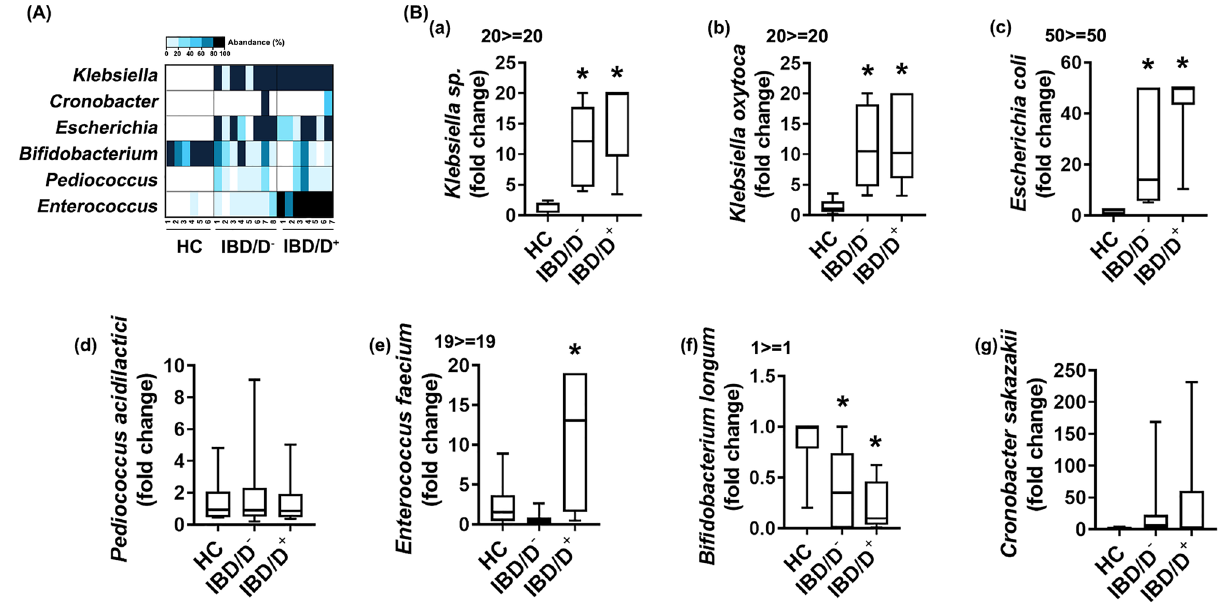
Figure 1. The fecal microbiota composition of patients with IBD/D − or IBD/D + and healthy individuals (HCs). ( A ) Effects on the levels of gut bacteria Klebsiella sp. , Cronobacter sp., and Escherichia sp. grown in the DHL agar plate, Bifidobacterium sp. in the BL agar plate, and Pediococcus sp. and Enterococcus sp. in the mEn agar plate. ( B ) Effects on the levels of gut bacteria Klebsiella sp. (a), Klebsiella oxytoca (b), Escherichia coli (c), Pediococcus acidilactici (d), Enterococcus faecium (e), Bifidobacterium longum (f) and Cronobacter sakazekii (g), assessed by qPCR. Data are shown as box plots (HC n = 6; IBD/D − n = 8; IBD/D + , n = 7). Means with same letters are not significantly different (p < 0.05). (b,c), Kruskal–Wallis test (nonparametric